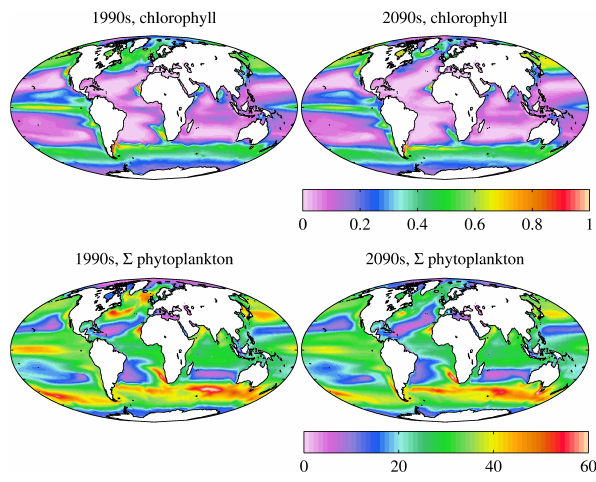
Fig. 13. Annual average 1990s (left) and 2090s (right) surface Fig.11. Annualaverage1990s( left )and2090s( right )surfacechlorophyll( top ;mgchl.m − 3 )andvertically–integrated phytoplanktonbiomass( bottom ;mmolNm − 2 ). chlorophyll (top; mgchlm − 3 ) and vertically integrated phytoplank- ton biomass (bottom; mmolNm − 2